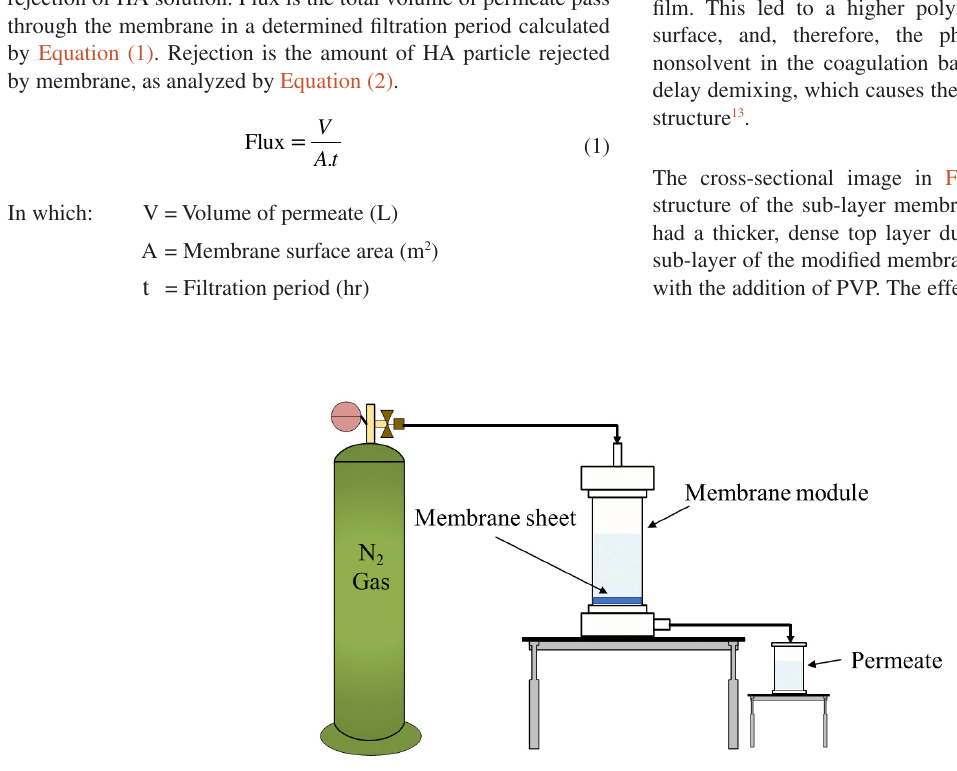
Figure 1. Experimental set up using PET